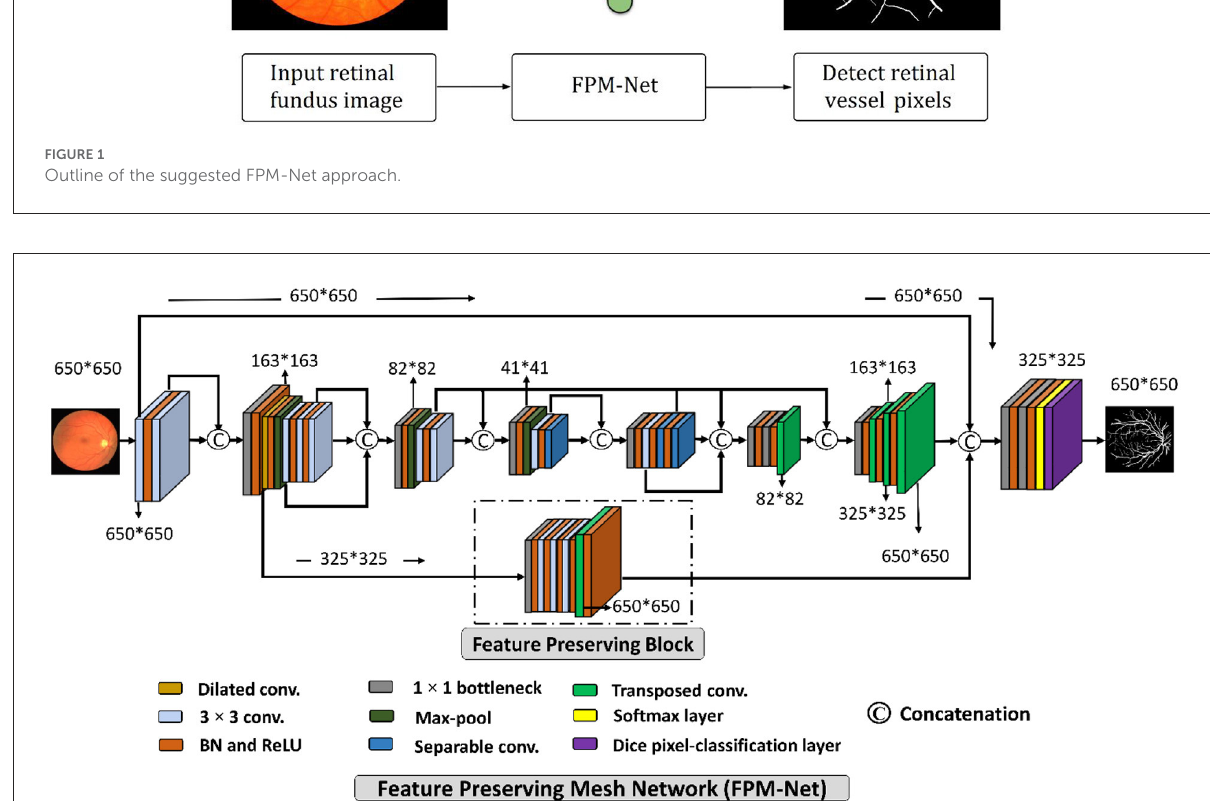
FIGURE2 The suggested Feature Preserving Mesh Network (FPM-Net) architecture for retinal vessels